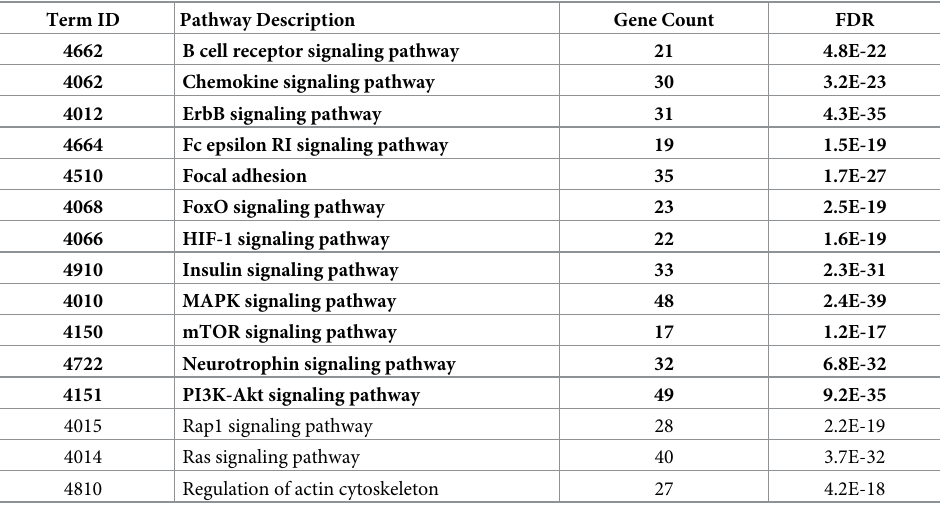
Table 4. Top 15 KEGG signaling pathways in the jejunum.